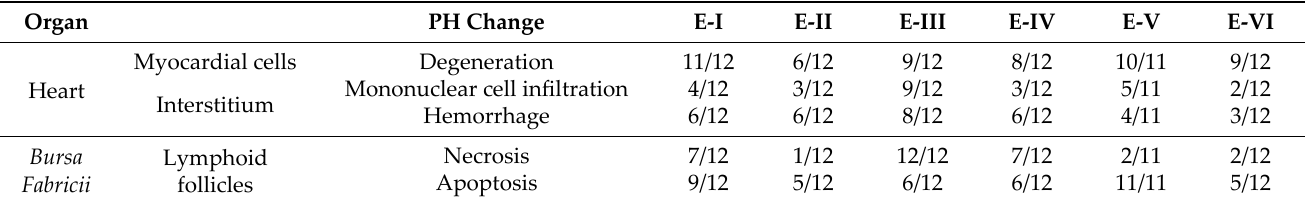
Table 9. The score of the PH changes in the heart and Bursa Fabricii of broiler chicks fed with diets containing the AFB1 and T‑2 toxin combination in relation to the numbers of animals